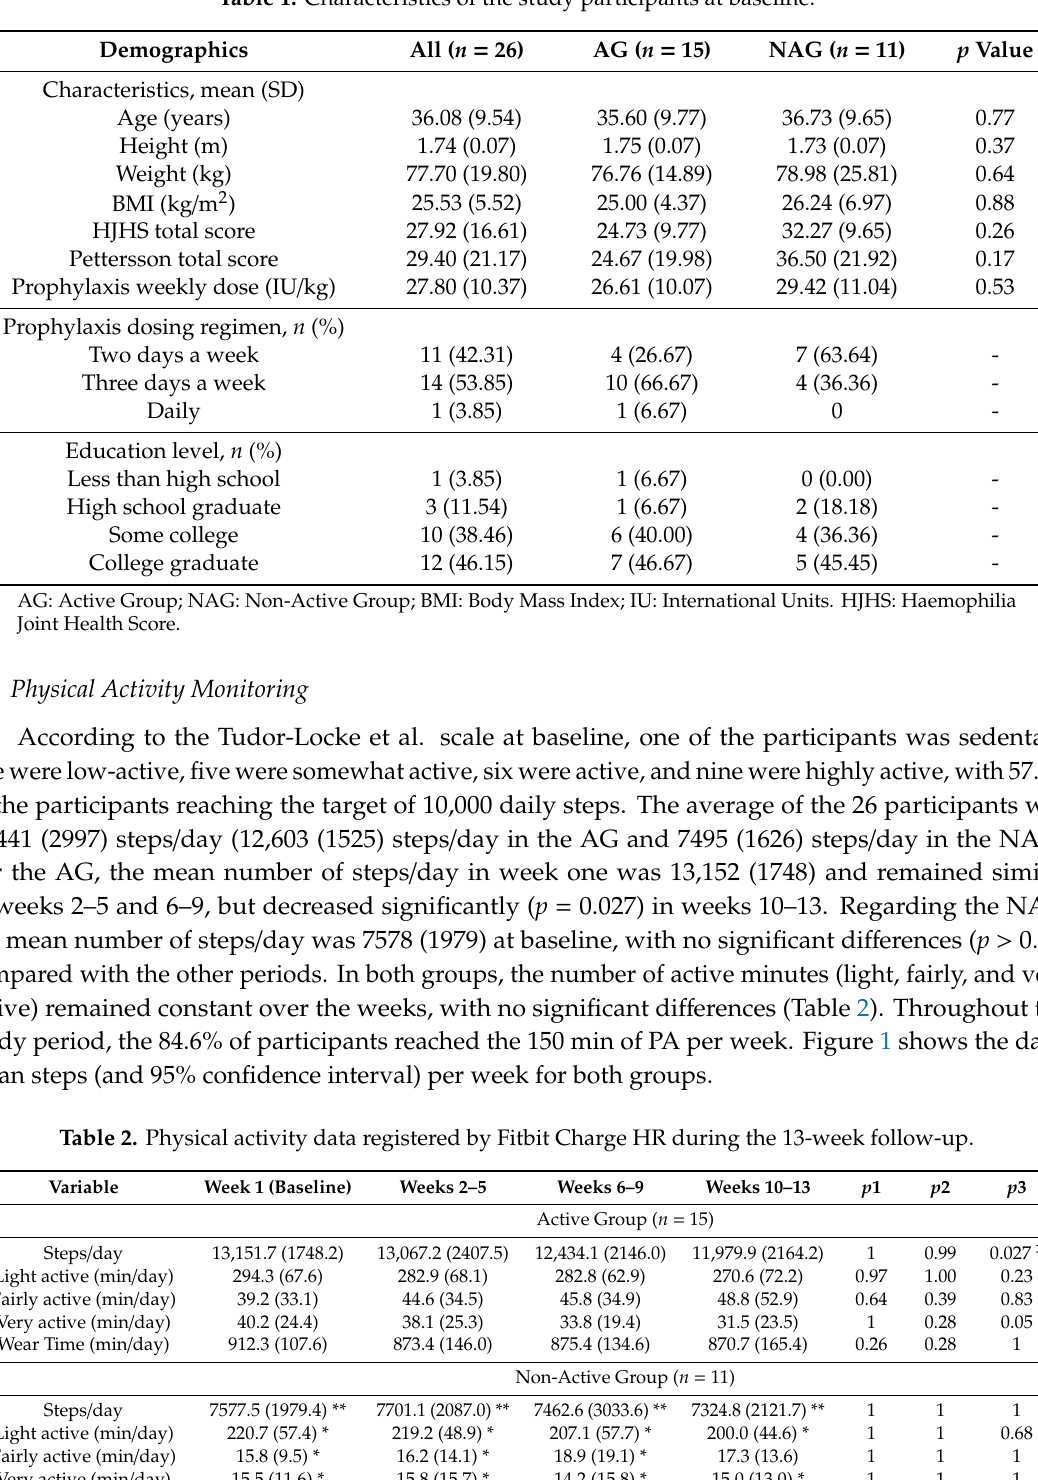
Table 1. Characteristics of the study participants at baseline.